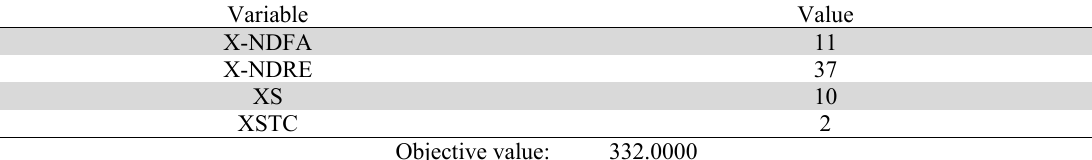
The results of solving the model by Lingo